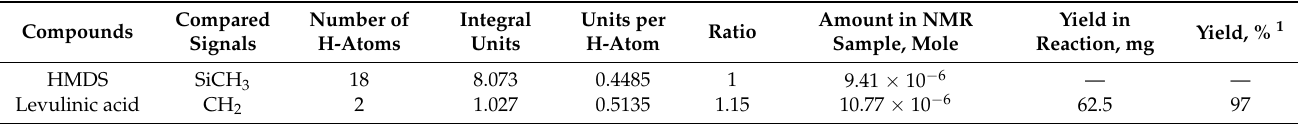
Table 2. The evaluation of levulinic acid yield from 1 H-NMR spectra signals (the Kuznechanka variety is given as an example).